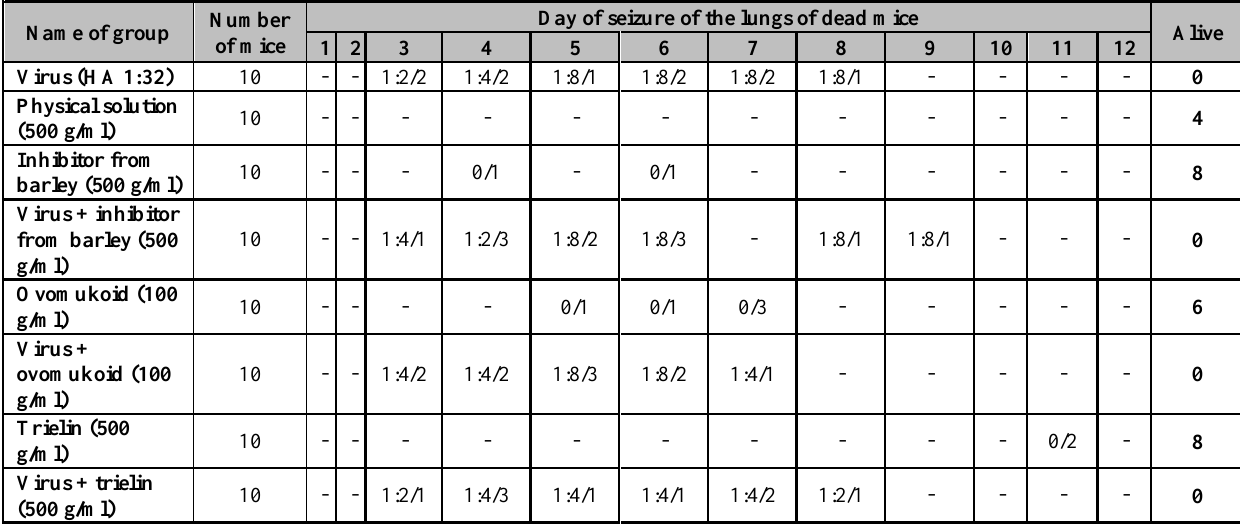
Table 2. The presence of hemagglutinating activity in the lungs of dead mice infected with a lethal dose of influenza virus A/P/R/8/34 and treated with trypsin inhibitors